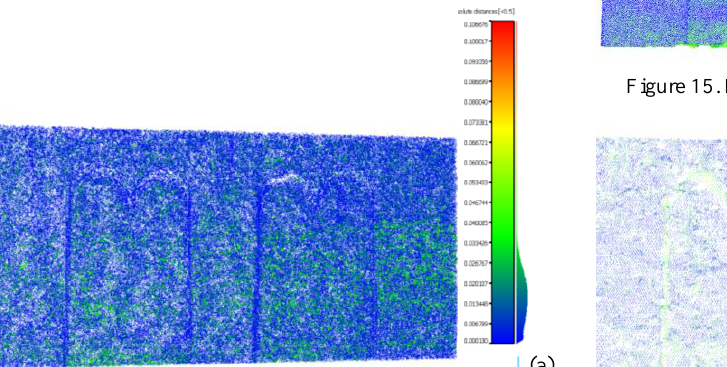
Figure 11. Discrepancies map between the TLS cloud and MicMac results.